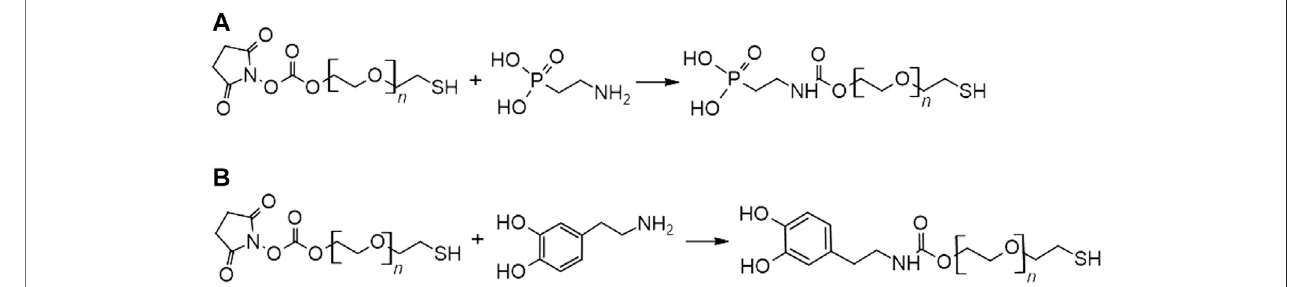
FIGURE 3 | Reaction scheme for synthesizing (A) SH-PEG-PA and (B) SH-PEG-DPA ( n (cid:2)